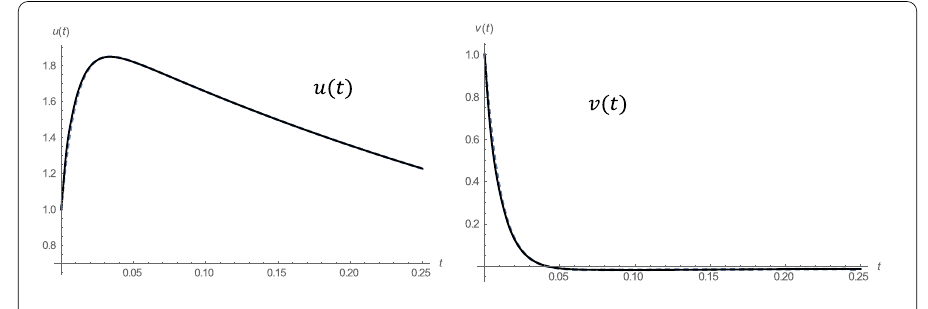
Figure 2 The behavior of RK solution of Example 4.1: __ exact; ... . approximated